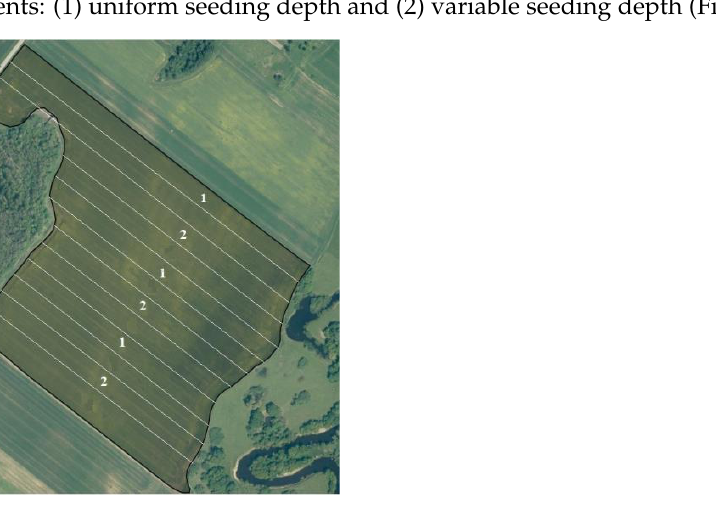
Figure 2. The distribution of seeding treatments in an experiment: (1) uniform seeding depth; (2) variable seeding depth.